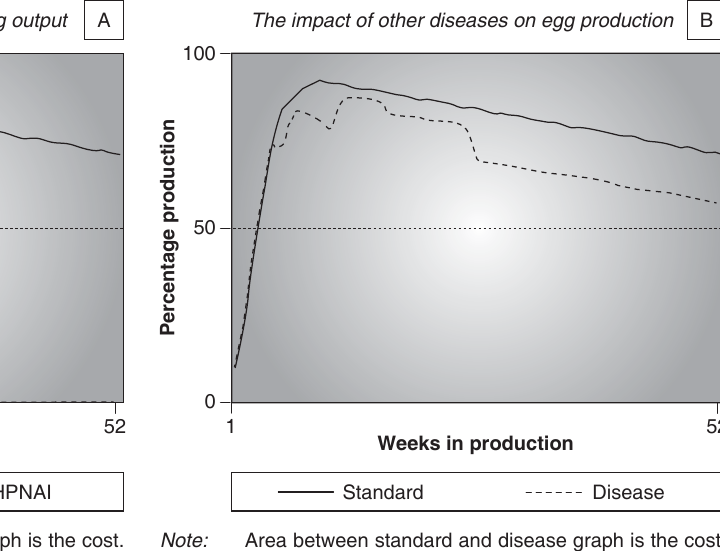
Disease Note: Area between standard and disease graph is the cost. Several other avian diseases cause partial loss of poul- try production. However, few other diseases attract cul- ling of the affected flock